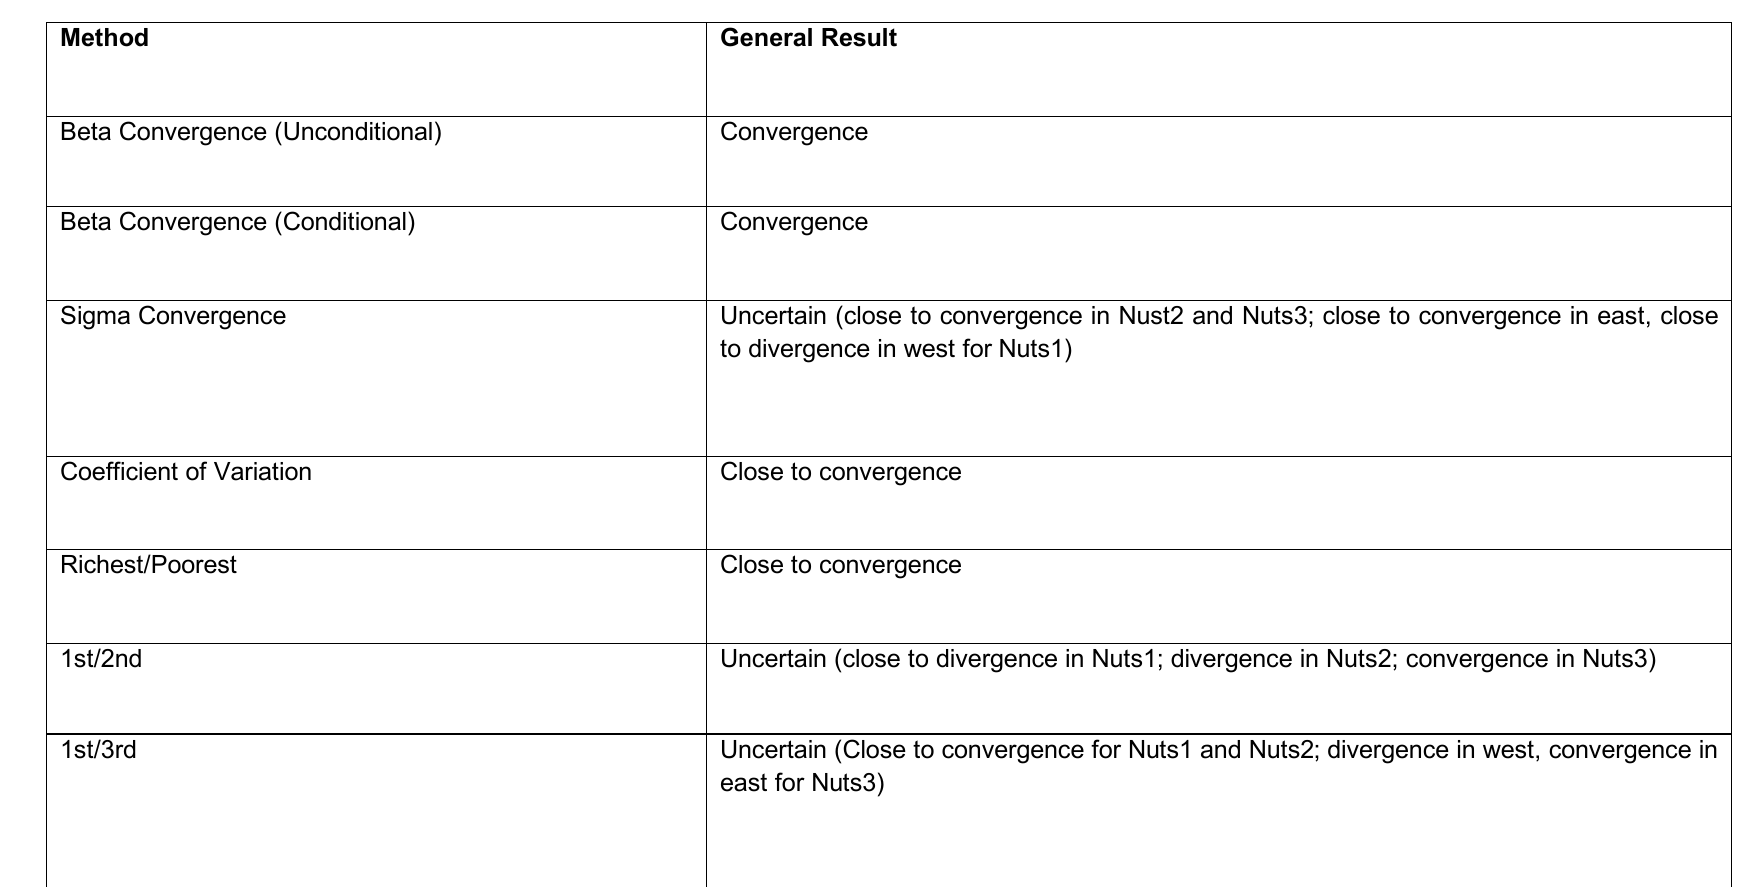
Table 8 given below summarizes the general result obtained from different models and techniques.